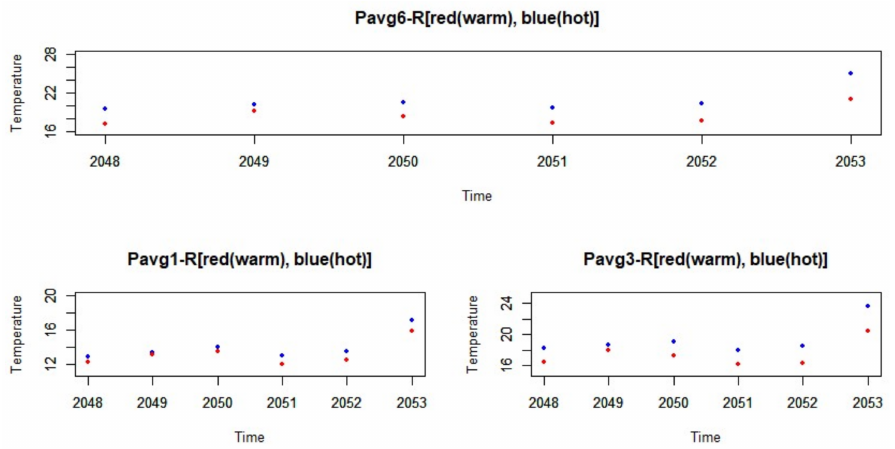
Figure 41. RCP 8.5 hot model (MIROC-ESM-CHEM) and RCP 8.5 warm model (IPSL-CM5A-MR) predictions for the period 2048–2053 (full dam steady-state), temperature in ◦ C.